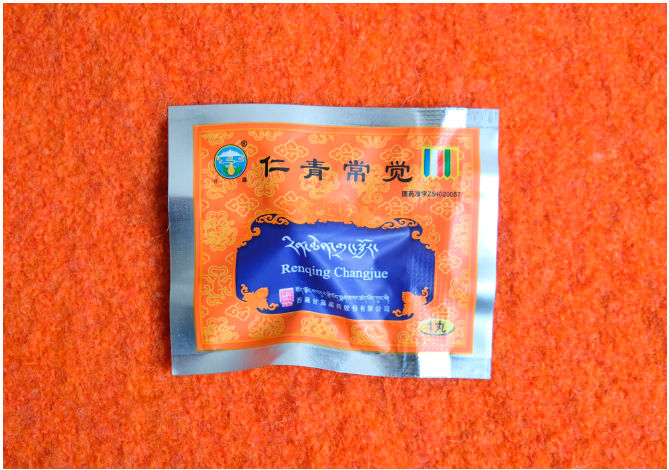
Figure 7. The packaged precious pill Rinchen Drangjor, sold as Renqing Changjue in Lhasa. Photo by